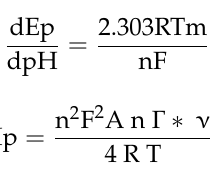
Figure 6. ( A ) CVs obtained for various scan rates (0.01 – 0.41 V/s); ( B ) d ependence of Ip and √υ; ( C ) d ependence of log Ip and log υ; ( D ) p lot of Ep vs. log